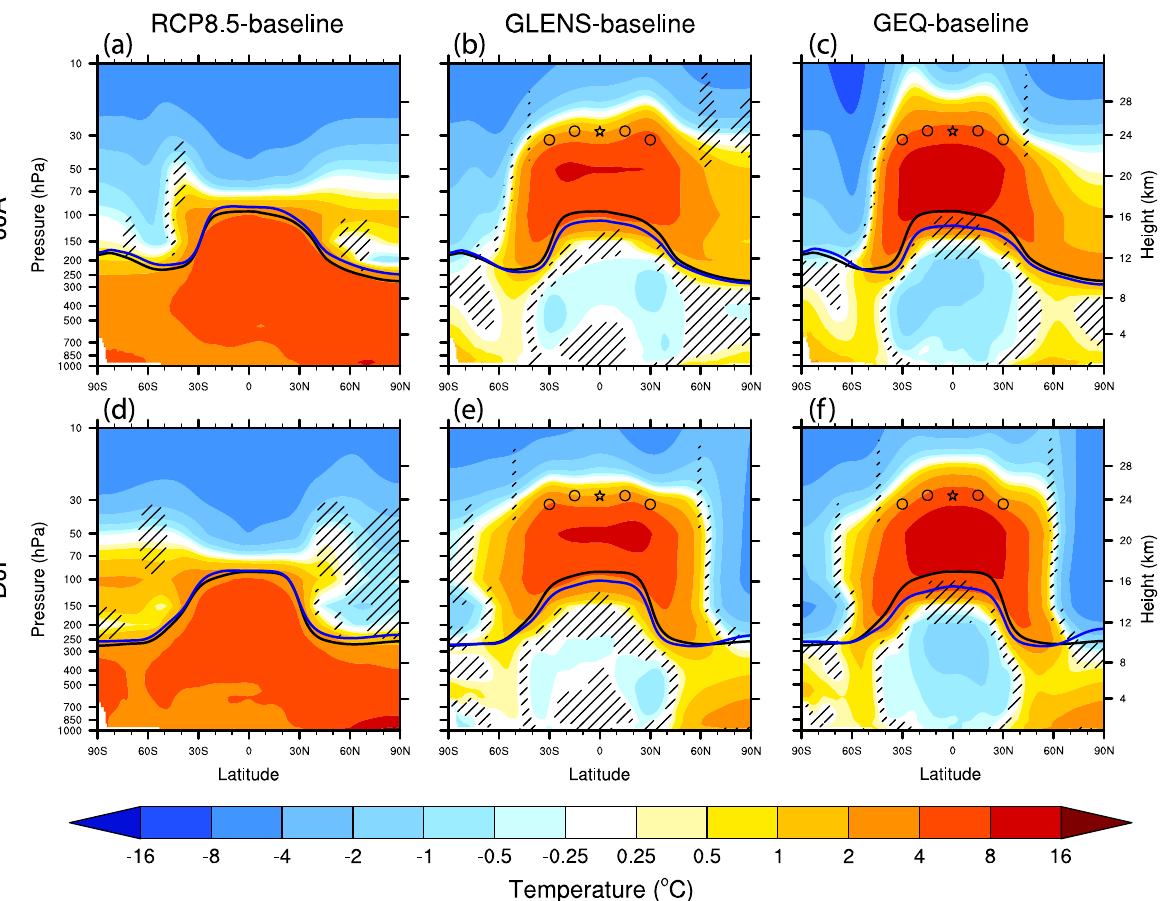
Fig. 1 Changes in zonally seasonal mean temperature. Changes in zonally averaged June – July – August (JJA, a – c ), December – January – February (DJF, d – f ) mean temperature (°C) in RCP8.5 ( a , d ), GLENS ( b , e ), and Equatorial injection (GEQ; c , f ) ensemble mean averaged over the period 2075 – 2095, relative to RCP8.5 averaged over years 2010 – 2030 ensemble mean (Baseline). Hatched areas are regions where changes are not statistically signi fi cant at the 5% level using the Student ’ s t test. The four circles indicate the four SO 2 injection locations in GLENS, and the star indicates the injection location in GEQ. The black solid line indicates the tropopause in the baseline, and the blue solid line indicates the tropopause in the perturbed GEQ and Solar1x1 simulations, there is a statistically signi fi cant hemispherically asymmetric tropospheric (from surface to 200 hPa) overcooling ranging from 0.2 to 2 °C in the tropics (Fig. 1 and Supplementary Fig. 1). Geoengineering maintaining the three temperature-related metrics at the baseline by stratospheric sulfur injection or solar dimming produces a weaker tropospheric overcooling than aerosol or solar geoengineering just maintaining global-mean surface temperature, respectively. The overcooling is mostly located near 30° S/N in the middle of the troposphere for maintaining T0, T1, and T2 targets at the baseline under GLENS and Solar3x3. At boreal mid- and high latitudes of the Northern Hemisphere, moderate winter warming appears in both solar dimming geoengineering ensembles. There is some stronger residual tropospheric warming during winter under both aerosol geoengineering ensembles, especially at the surface, which resembles a classic winter warming signal after volcanic eruptions 47,48 . The residual tropospheric temperature changes under geoen- gineering are a consequence of differences in the seasonality and in the latitudinal and vertical structures of the CO 2 and sulfate aerosol forcings (e.g., Henry and Merlis 49 ; Govindasamy et al. 50 ). They are associated with changes in tropical static stability and meridional temperature gradient, which are quoted in Table 2 and Supplementary Table 1 for each geoengineering experiment together with associated standard errors. In the GEQ and